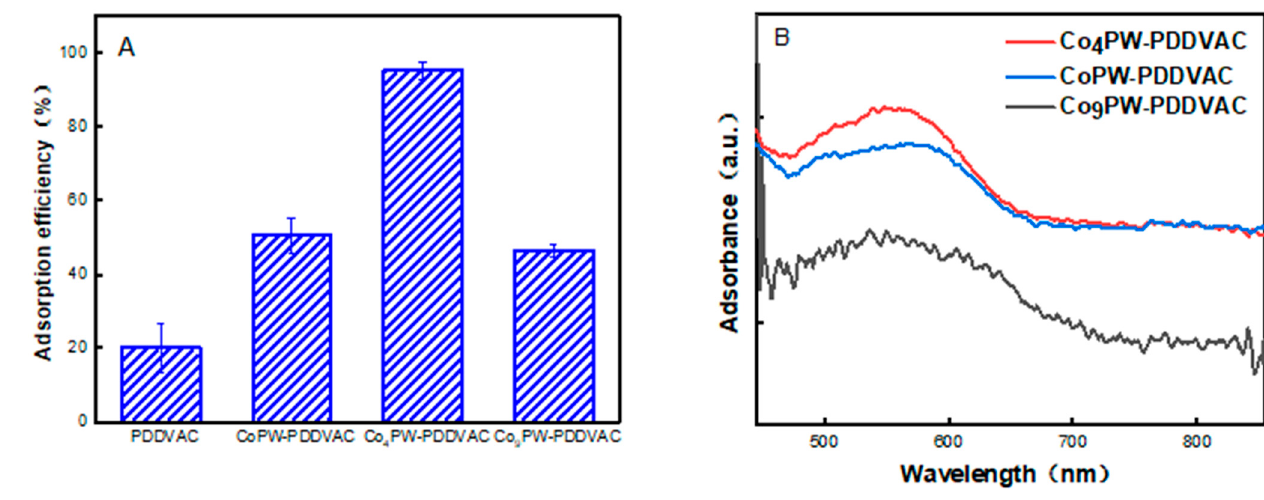
Figure 2. ( A ) The PrK adsorption performance of PDDVAC, CoPW–PDDVAC, Co 4 PW–PDDVAC, and Co 9 PW–PDDVAC. ( B ) Ultraviolet diffuse spectra of CoPW–PDDVAC, Co 4 PW–PDDVAC, and Co 9